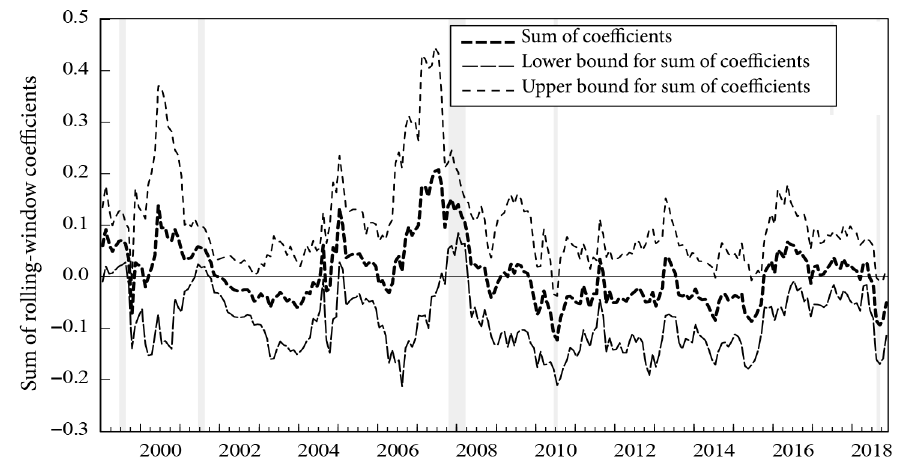
Figure 2. Bootstrap estimates of the sum of the rolling-window coefficients for the impact of GEPU on